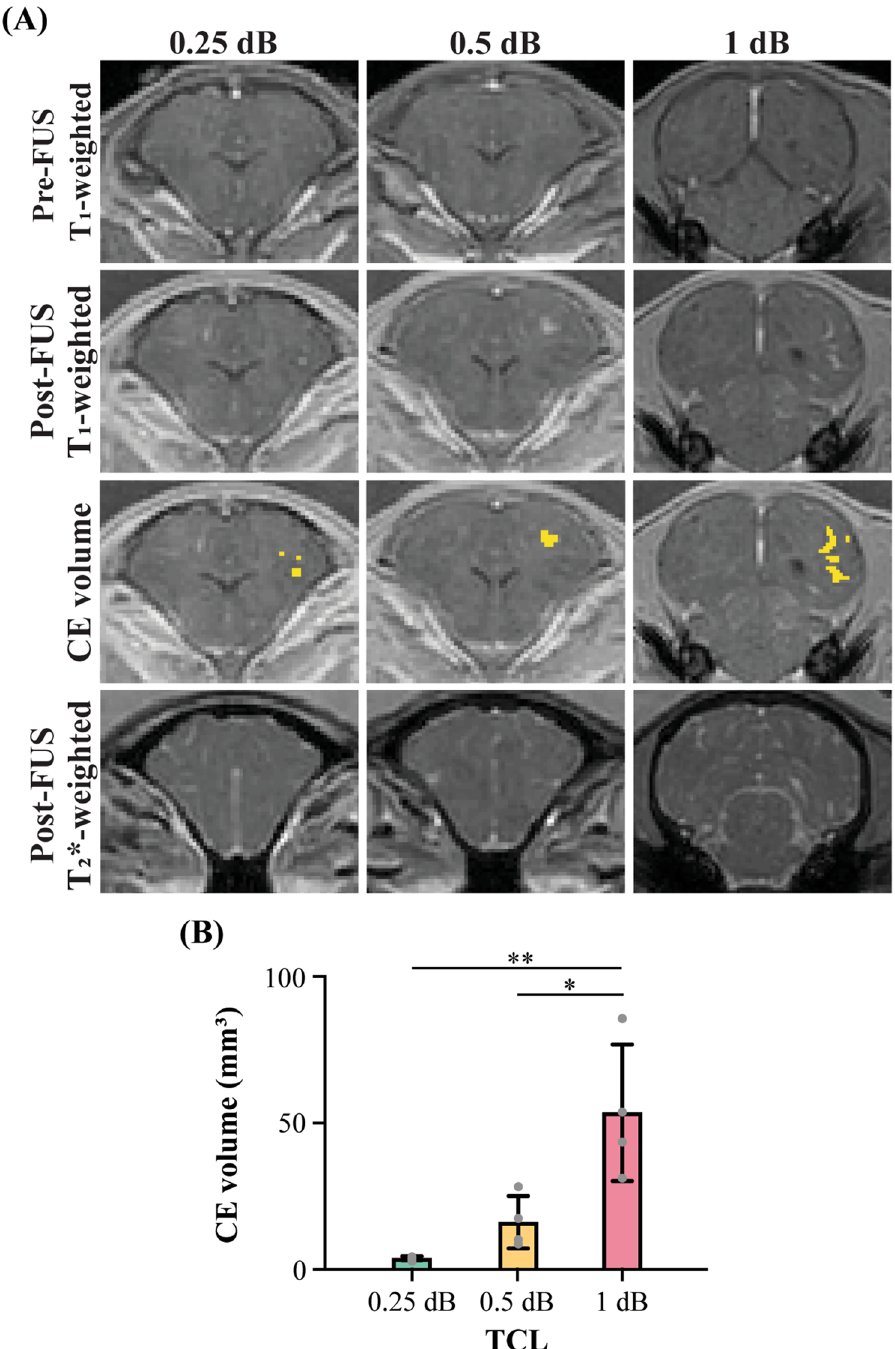
Figure 3. The proposed feedback controller achieved different levels of BBB opening in pigs. ( A ) Representative contrast-enhanced (CE) T1-weighted MRI scans were acquired before (first column) and after FUS (second column) to quantify CE volume (i.e., yellow-shaded area in the third column). The representative T2*-weighted MRIs acquired at the same position as the T1-weighted MRIs (bottom column) ( B ) The CE volume at each TCL. The bar plot in ( B ) shows the mean and standard deviation. Each circular point represents the result obtained from each target. (Tukey’s test * P < 0.05; ** P < 0.01; *** P <